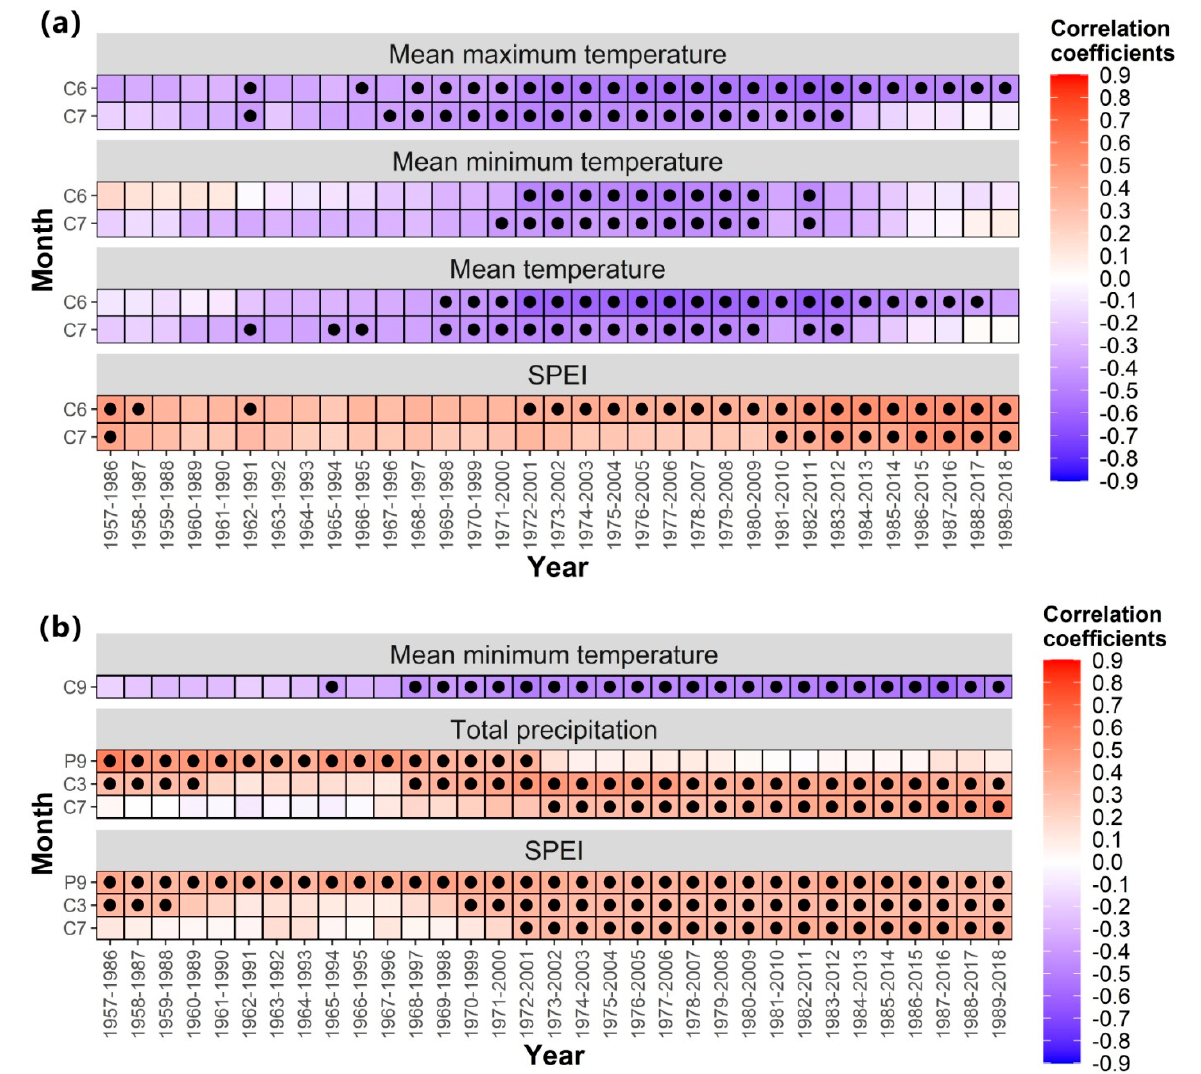
Figure 8. Moving correlations between the tree-ring width chronologies and climate factors in two regions. ( a ) Central region, and ( b ) isolated mountains.